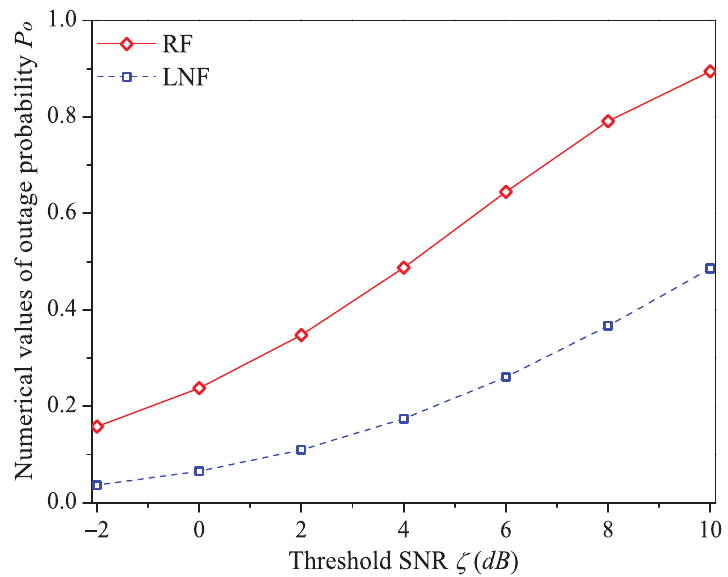
Figure 8. The numerical values of outage probability P o with different ζ